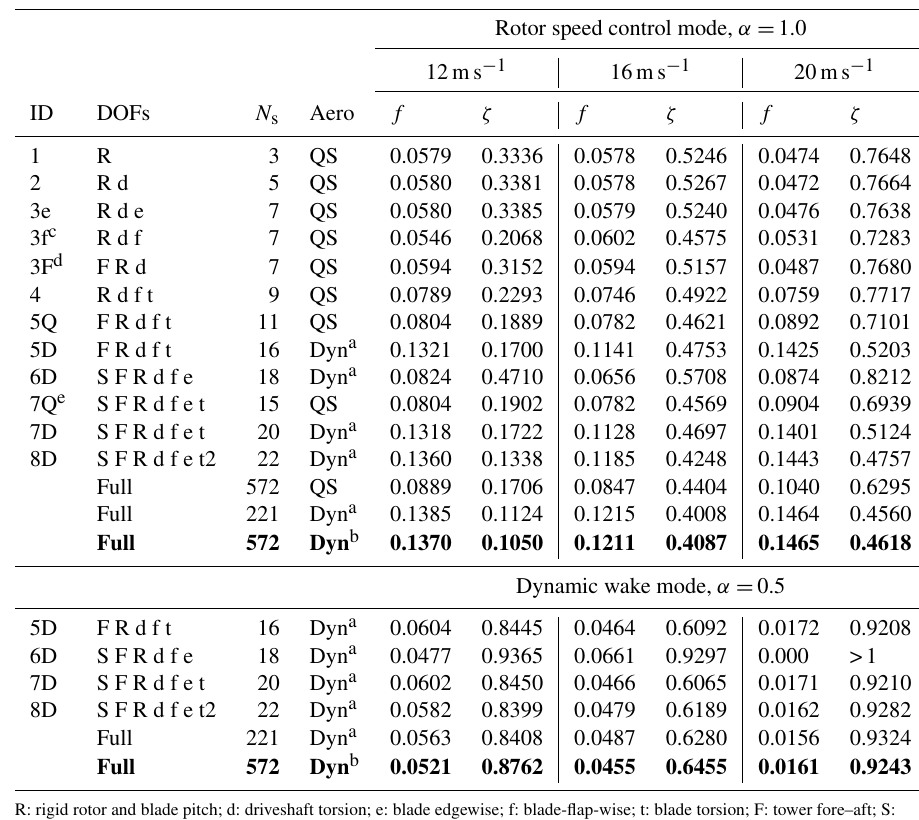
Table 1. Natural frequencies and damping ratios of the rotor speed control mode (using the baseline gains) and dynamic wake mode (at half the baseline gains), obtained from models with various degrees of freedom (DOFs). Results obtained with the reference high- fidelity model are highlighted in bold. Model 5D is recommended as a minimum model for basic controller gain tuning. Aero indicates whether the aerodynamics were quasi-steady (QS) or included transient dynamics (Dyn). BEM: blade element momentum method. For other abbreviations, see the table in Appendix A.